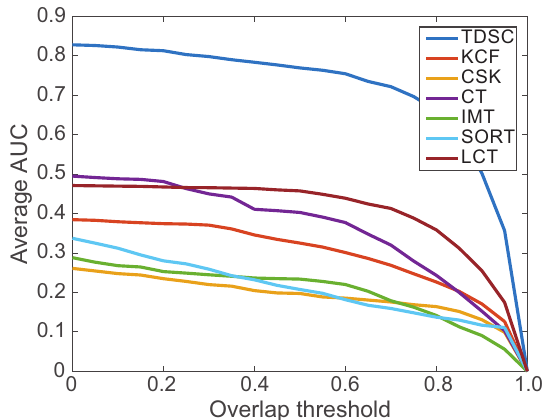
Fig. 4 Overall performance curve.